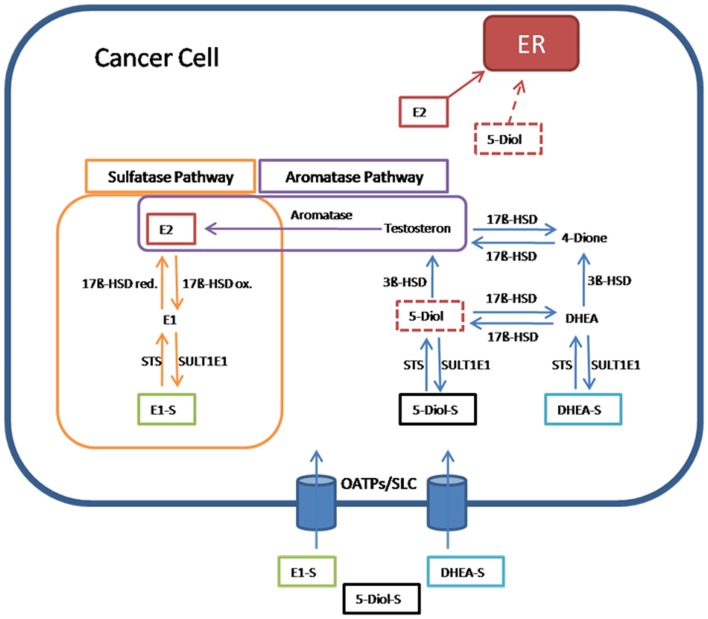
Pathway for 17β-estradiol formation in cancer cells. Estrone-sulfate (E1-S), a precursor for the most active estrogen 17β-estradiol (E2), androstenediol (5-Diol-S), and dehydroepiandrosterone sulfate (DHEA-S) are taken up from the blood into cancer cells by transporters from the organic anion transporting polypeptide family (OATPs) and other members of the solute carriers (SLCs). In the sulfatase pathway, E1-S is converted through steroid sulfatase (STS) to estrone (E1), which is transformed via the reductive 17β-hydroxysteroid dehydrogenases (17β-HSD red) to E2. E2 as the most active estrogen binds and activates estrogen receptors (ERs). In the reverse pathway from E2 to E1-S, the oxidative 17β-hydroxysteroid dehydrogenases (17β-HSDox) convert E2 to E1. The estrogen sulfotransferase SULT1E1 inactivates estrogens by adding sulfate to hydroxyl-groups on the steroid ring. In the aromatase pathway, E2 is produced from testosterone by the aromatase. Testosterone itself is formed from 5-androstenediol (5-Diol) via 3β-HSD. 5-Diol is generated by the removal of the sulfate from 5-Diol-S via STS. Also 5-Diol can activate ER, but with lower affinity than E2. In an alternative way, testosterone is derived from the conversion of DHEA-S to androstenedione (4-Dione) via DHEA. Finally, 17β-HSD transforms 4-Dione to testosterone (55).